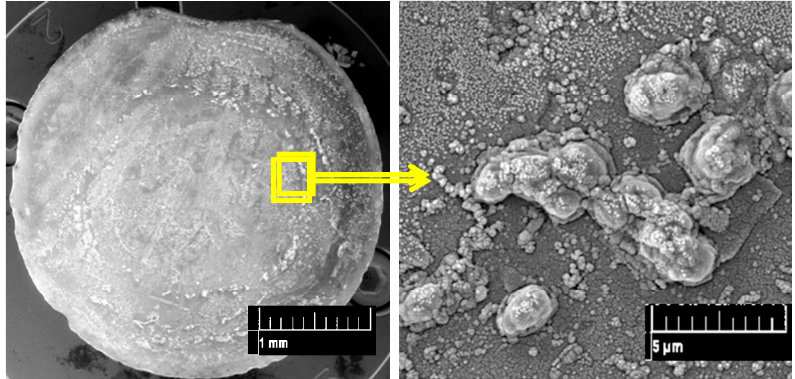
Figure 5. Variability of intensities of the first bioluminescence maxima (B1) and times of their appearance (T1) of the optical fiber elements with P. putida TVA8 encapsulated in silica hydrogel induced repeatedly with toluene (26.5 mg/L). Average ± standard deviations of two reproduced experiments are shown. The same tapered optical element was used in both experiments.